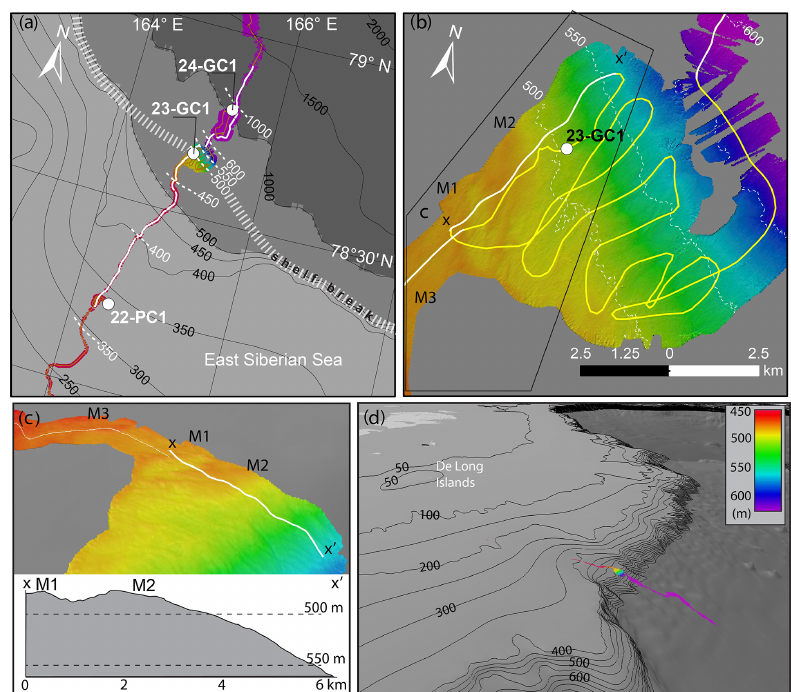
Figure 7. Multibeam mapping results. (a) Ship track and extent of mapping in the study area. Measured depths (white numbers and dashed lines) are shown in comparison with gridded depths in IBCAO. (b) Surveyed region on the outer shelf where the sedimentary mounds (grounding zone deposits) (M1, M2 and M3) are identified in the sub-bottom data. (c) Oblique view and bathymetric cross section of the interpreted grounding zone deposits (d) Oblique view of the outer East Siberian shelf with the De Long Islands and New Siberian Islands in the upper left. Multibeam data are overlain on